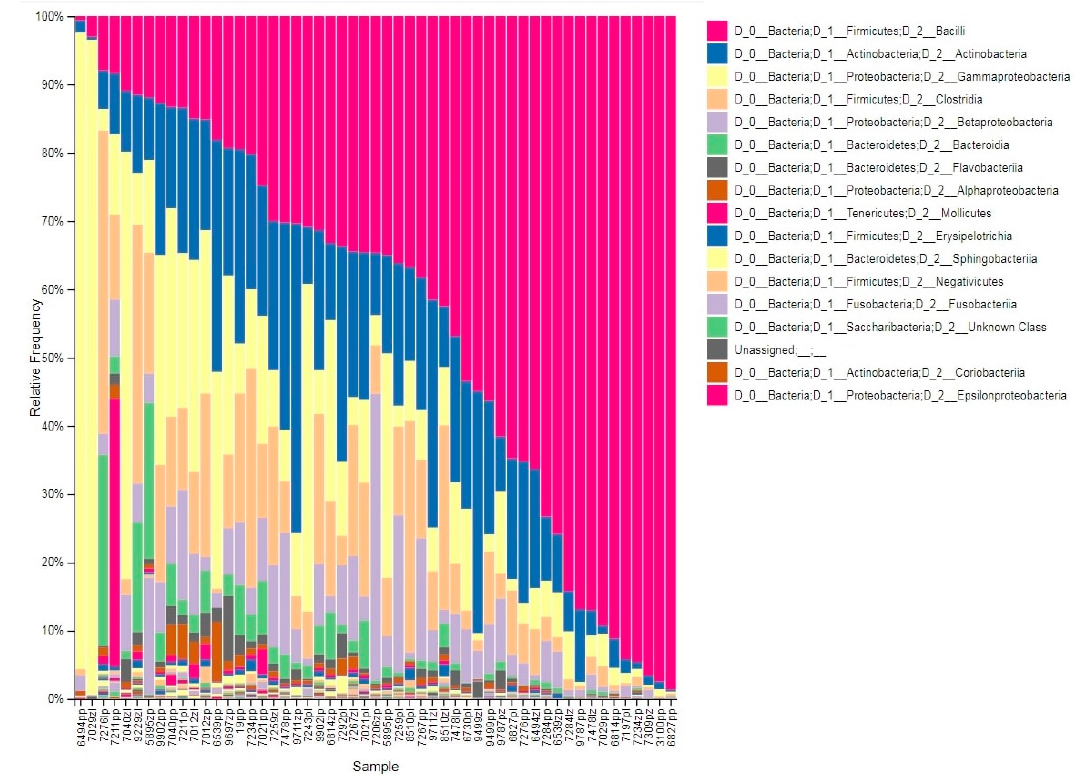
Figure 1. The relative abundance of major bacterial phyla present in milk samples.